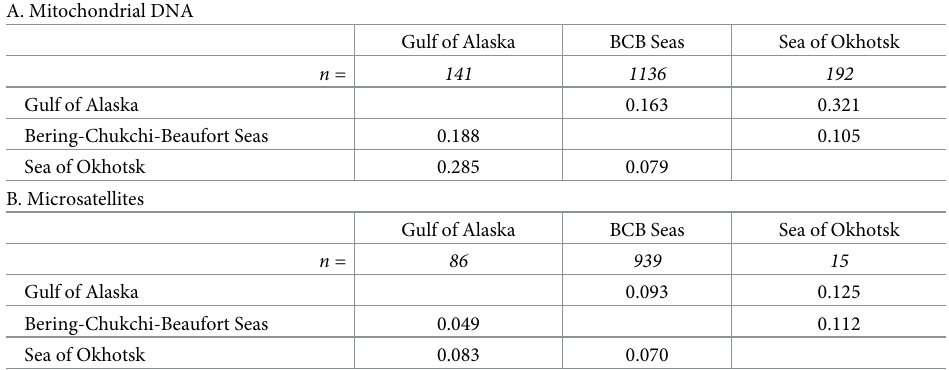
Table 2. Macrogeographic patterns of population differentiation in beluga whales in the north Pacific Ocean: (A) within mitochondrial DNA and (B) across eight microsatellite loci. Values for the frequency-based statistic, F st , are below the diagonal, values for the distance-based statistic, F st (mtDNA) and R st (nDNA), are above the diagonal. All P- values from homogeneity tests, based on 50,000 permutations, were significant at p < 0.0001. n denotes sample size. A. Mitochondrial